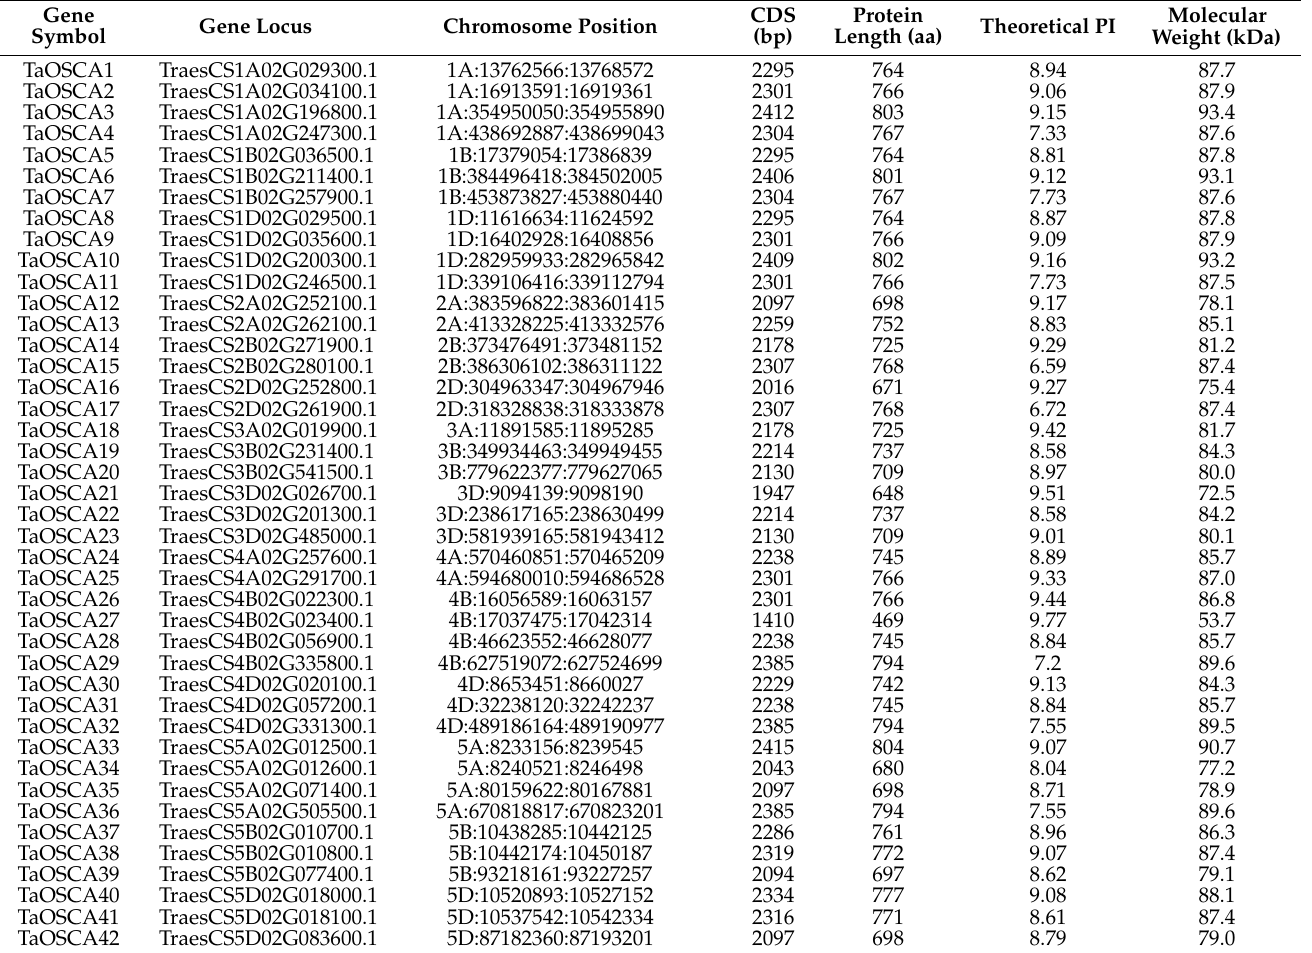
Table 1. Detailed information of the 42 predicted OSCA proteins in T. aestivum . Gene Gene Symbol